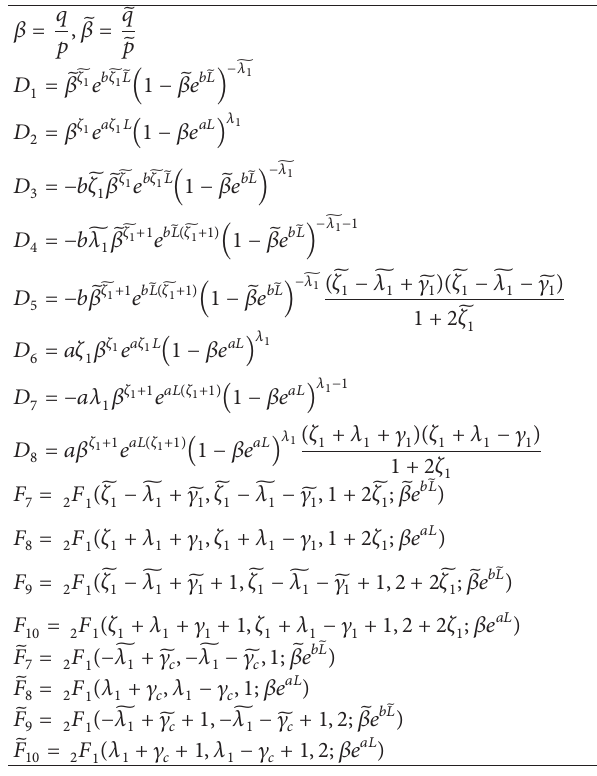
Table 3: The constants given in (33) and